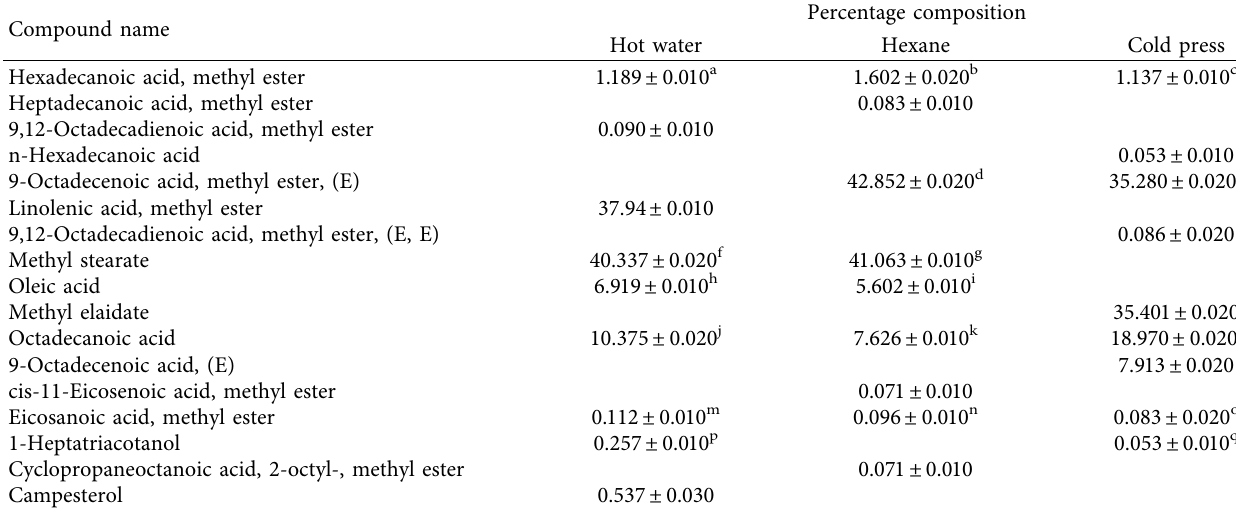
Table 4: Fatty acid analysis of A. foribunda butter extracted by hexane, cold press, and hot